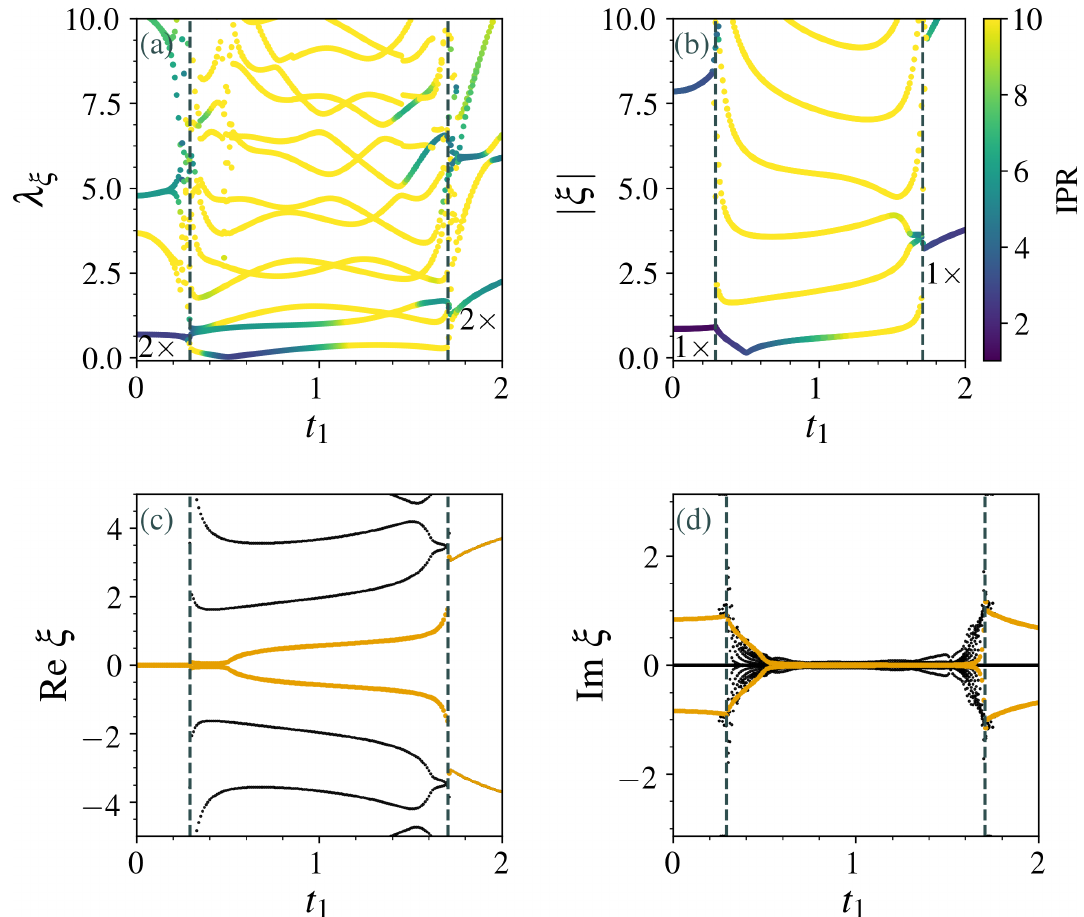
Figure 8: Singular values (a) and eigenvalues (b-d) of the biorthogonal entangle- ment Hamiltonian H RL as a function of t for γ = µ = 0.5. The total system is of 1 E length L = 201 and we consider a subsystem of size l = 40 unit-cells. In (a-b), col- ors represent the bilocalized inverse participation ratio of the corresponding singular modes I PR SVD and of the eigen modes I PR RL (see Eqs. (55) and (55) in App. B). In (c) and (d), we highlight the eigenvalues with lowest absolute real part. In the phase “H-Topo”, we observe two localized edge states with purely imaginary ener- gies. These states are nonetheless not topologically stable. The intermediate phase “nH-Topo” has non-separable energy bands, which leads to a non-local entanglement = 1 ± 1 (cid:112) Hamitlonian and delocalized modes. The phase transitions occurs at t , as 1 2 predicted by the PBC Hamiltonian, and are marked by the dashed vertical lines. Sin- gular values and eigenvalues transition